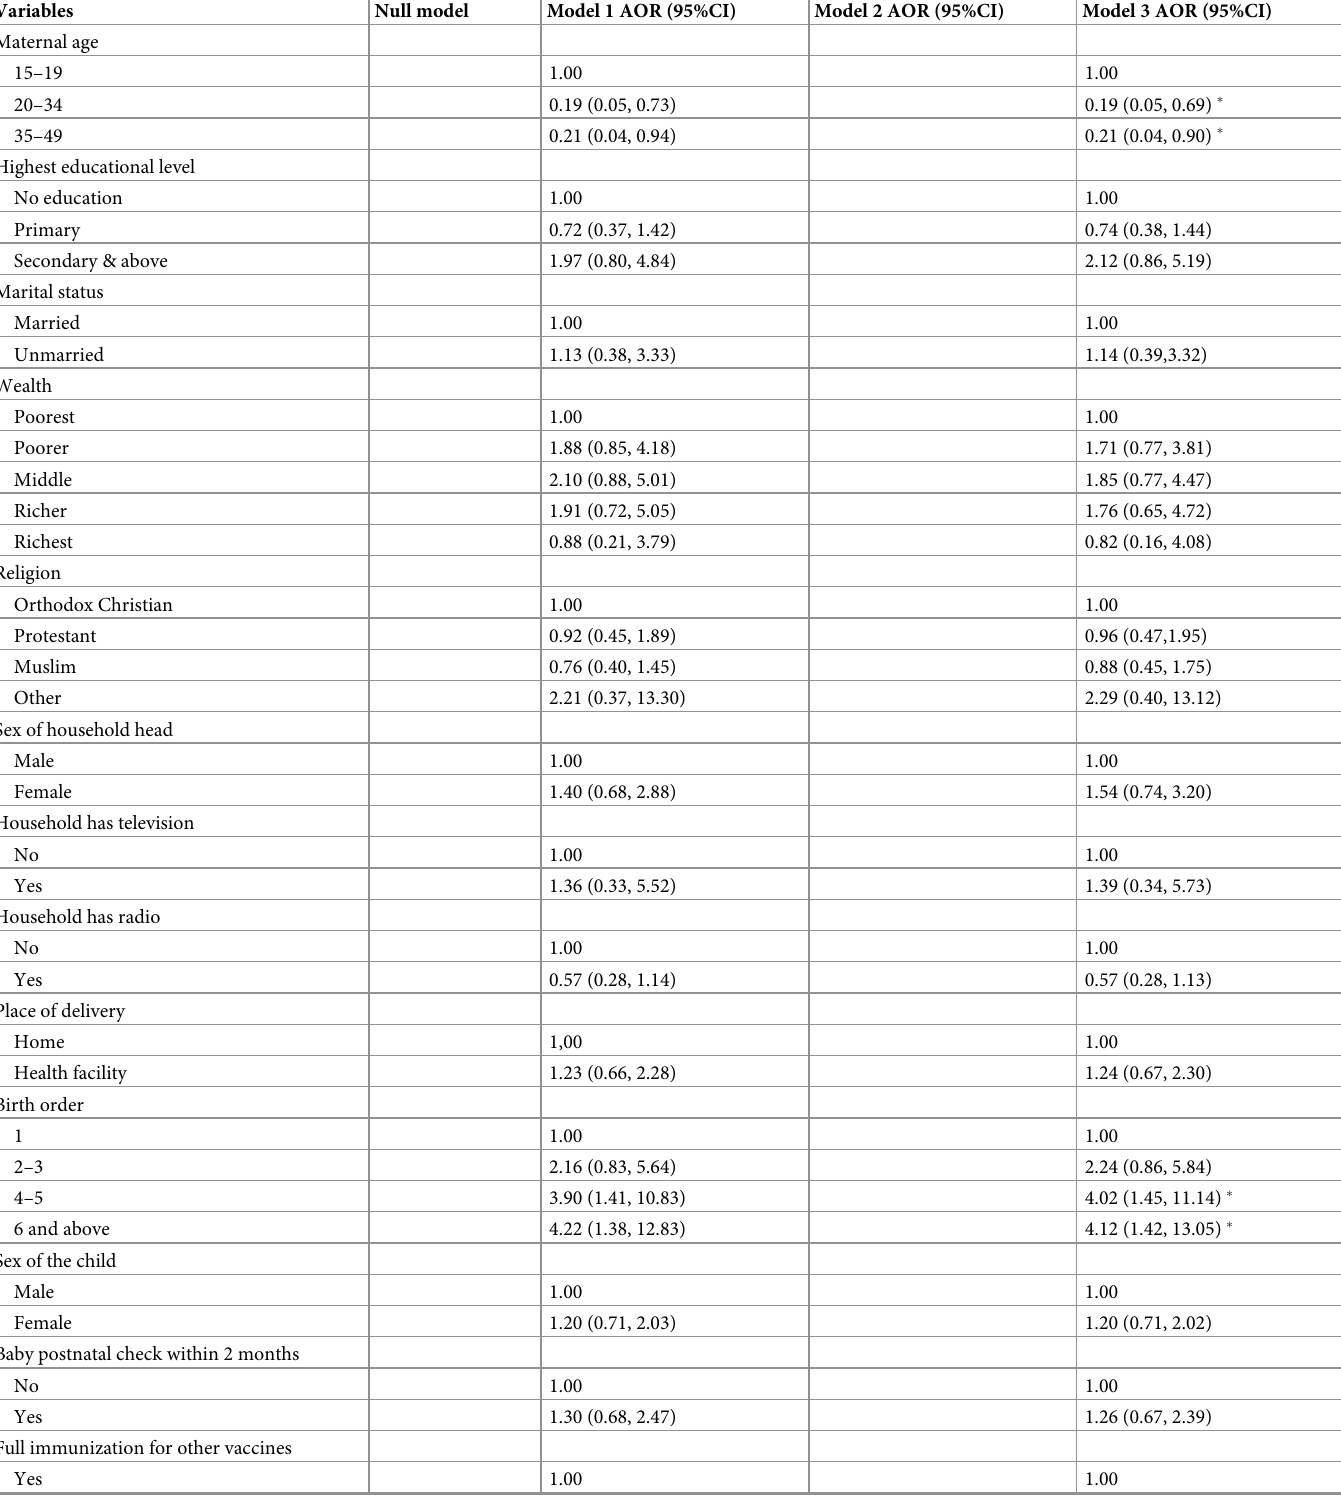
Table 2. Multilevel analysis for assessing factors associated with uptake of MCV2 in